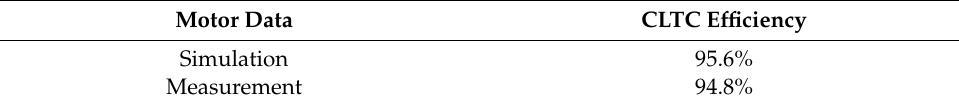
( b ) Figure 17. Experimental result. ( a ) Test bench; ( b ) measured efficiency map.